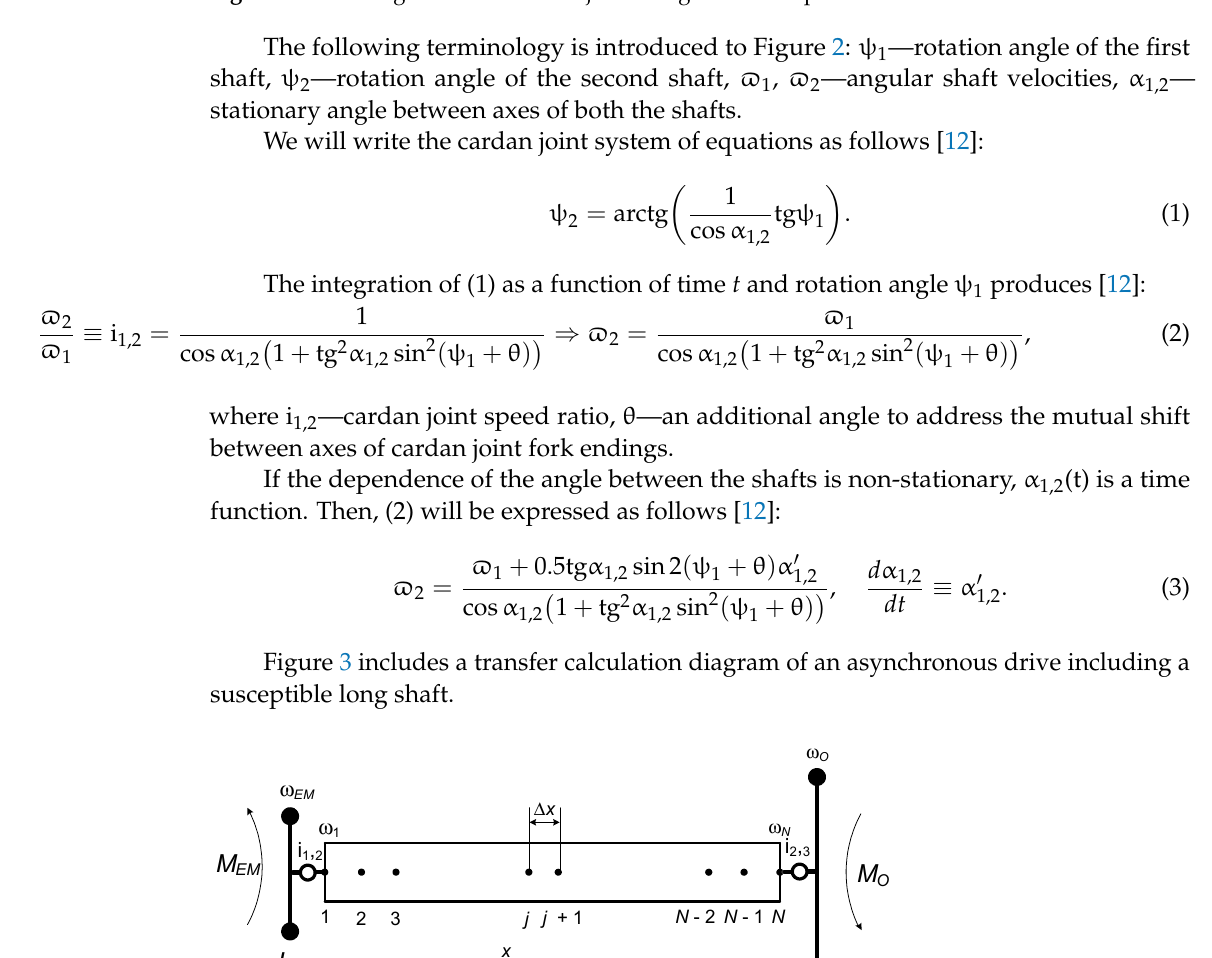
Figure 2. Basic diagram of the cardan joint in a general interpretation.